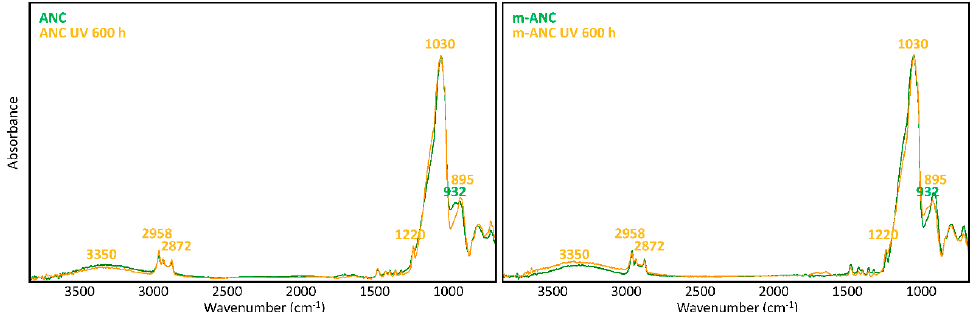
Figure 6. μ -FTIR spectra (ATR mode) of ANC and m-ANC films on glass slides before and after UV ageing for 600 h.